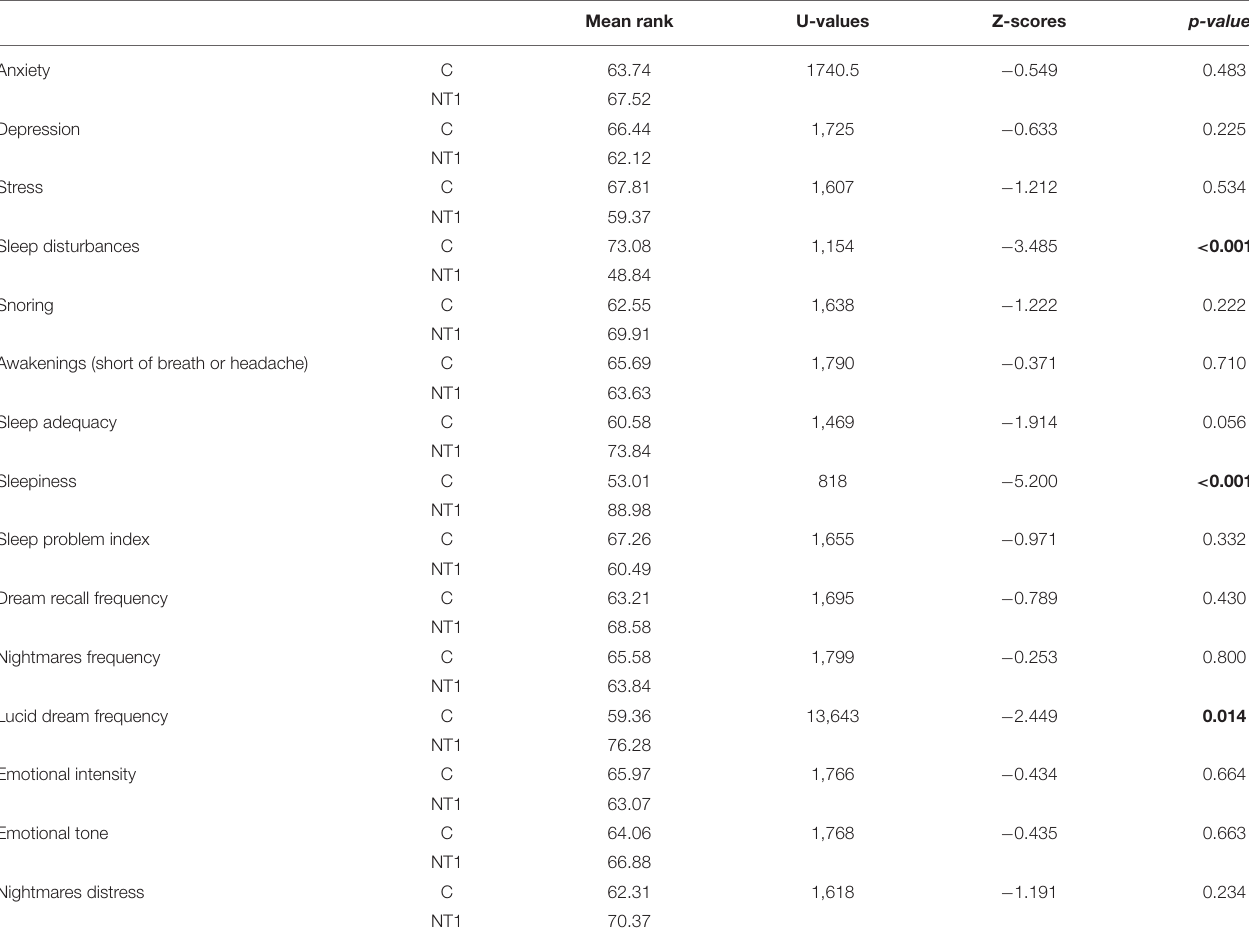
TABLE 2 | Mean rank of psychological, sleep and dream measures and results of statistical comparisons (Mann-Whitney U Test) between controls and narcoleptic patients.